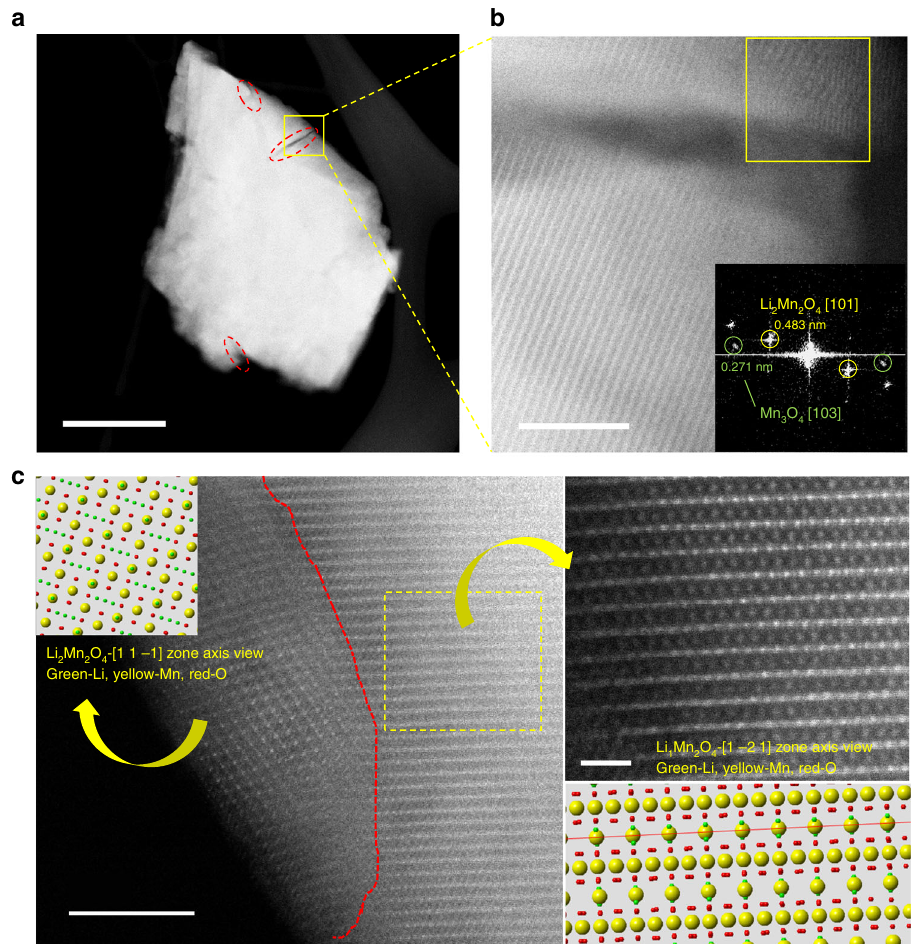
Fig. 3 Visual observations of particle morphology and phase distribution from STEM-HAADF. a The STEM imaging of LMO particle after 25 cycles. b The high-resolution STEM imaging for the crack of a . c Visual atomistic-level observation of detailed structure and atomic occupancy for cycled LMO sample. Scale bars, 200 nm ( a ); 5 nm ( b , c ); 1 nm (enlarged fi gure on the right side of c